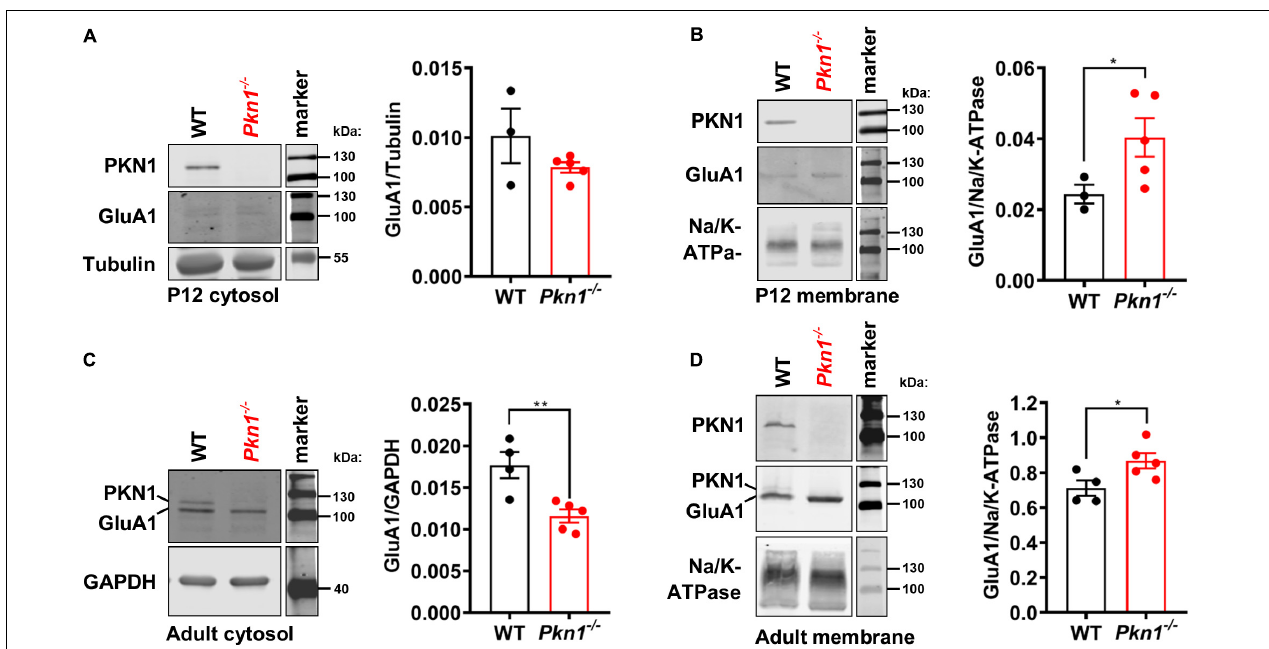
FIGURE 3 | Postnatal and adult Pkn1 − / − animals show enhanced membrane-association of GluA1. (A) The detergent-soluble cytosolic fraction of extracts prepared from P12 old WT and Pkn1 − / − hippocampi was probed for the loading control Tubulin and GluA1 ( P = 0.393, unpaired t -test). (B) The detergent-insoluble membrane fraction of extracts prepared from P12 old WT and Pkn1 − / − hippocampi was probed for the loading control Na + /K + -ATPase and GluA1 (* P = 0.0416, unpaired t -test). (C) The detergent-soluble cytosolic fraction of extracts prepared from adult WT and Pkn1 − / − hippocampi was probed for the loading control GAPDH and GluA1 (** P = 0.0075, unpaired t -test). (D) The detergent-insoluble membrane fraction of extracts prepared from adult WT and Pkn1 − / − hippocampi was probed for the loading control Na + /K + -ATPase and GluA1 (* P = 0.0430, unpaired t -test). All data is presented as individual n -values with mean ± S.E.M. Images of PKN1 in (A,B) were derived from a second blot, loaded in the same order. All markers in the representative blots are shown in separate lanes as samples were not next to the markers in the